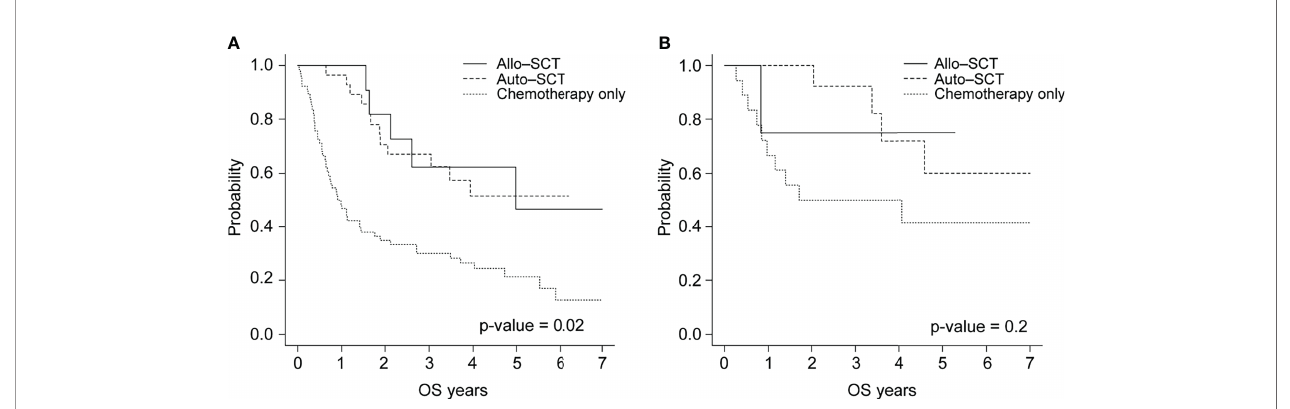
FIGURE 3 | Overall survival of patients with (A) EBV-positive or (B) EBV-negative PTCL by treatment type (allogeneic HSCT, autologous HSCT,